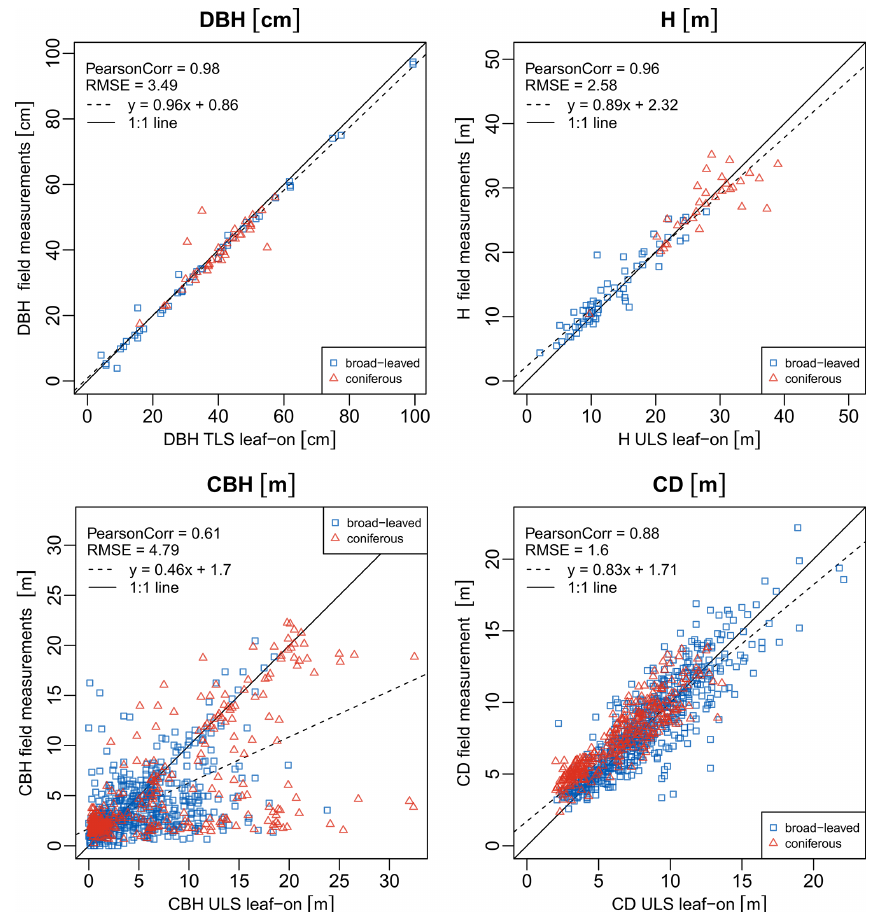
Figure 10. Scatter plots of metrics computed from tree point clouds and measured in the field. Pearson correlation, root-mean-square error and the equation of a linear model fit to the data are given. DBH is the diameter at breast height, H is the tree height, CBH is the crown base height and CD is the crown